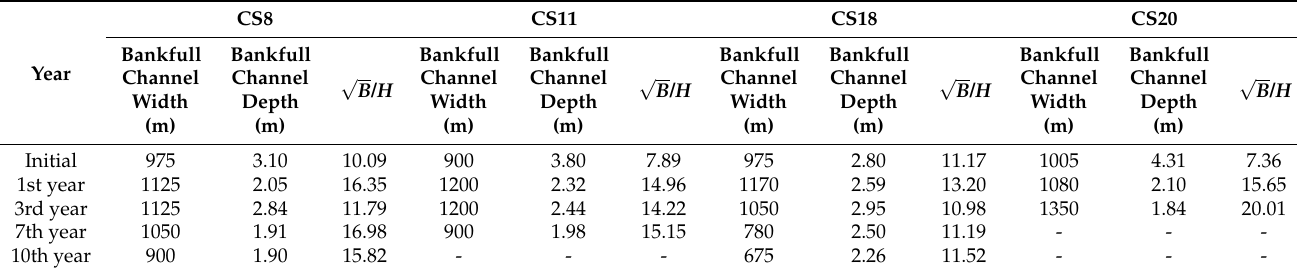
Table 3. Statistics of the bend section shape parameters unconstrained by the four projects.